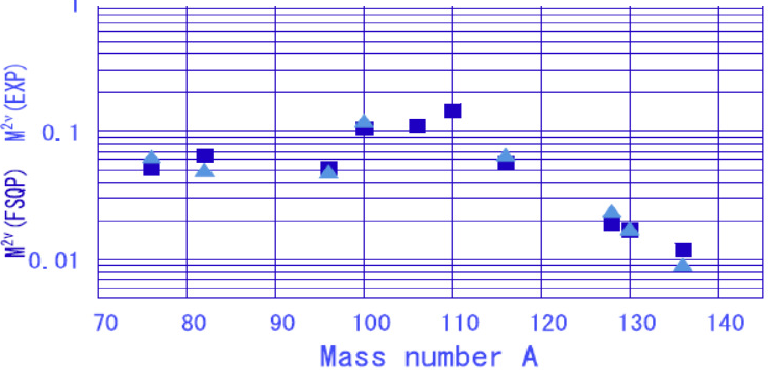
Figure 6. Two-neutrino DBD NMEs (triangles ) derived from the observed 2-neutrino DBD rates and the (fermi-surface) quasi-particle (FSQP) model NMEs (squares) based on the experimental quenching coefficients for single- β GT NMEs